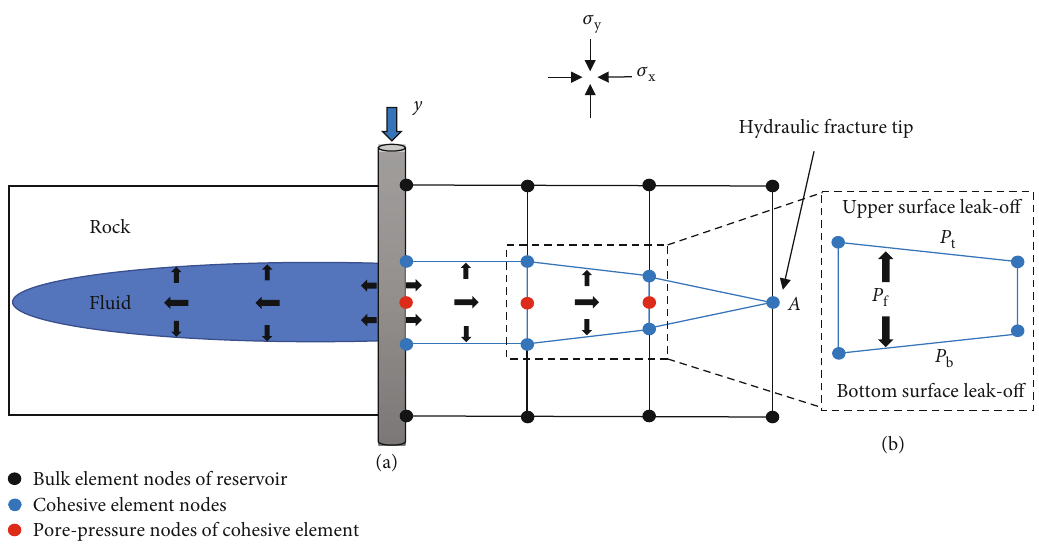
Figure 1: Fluid fl ow in pores and fractures during hydraulic fracturing.